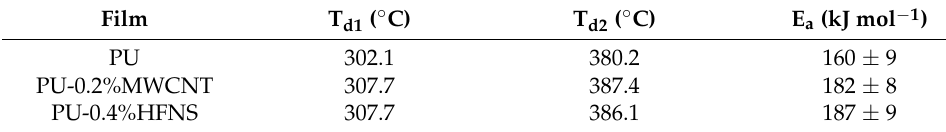
Table 1. Thermal degradation parameters from MTGA experiments.